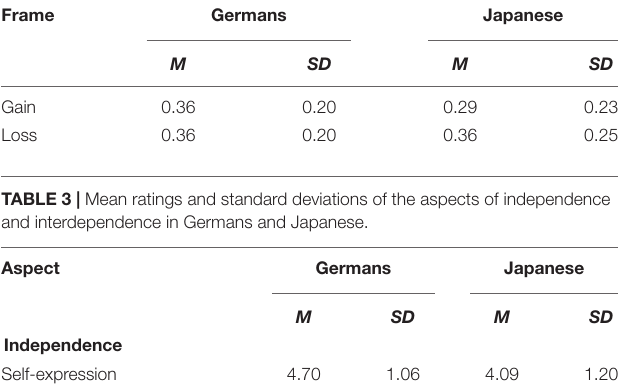
TABLE 2 | Mean AUCs and standard deviations in gain and loss frames in Germans and Japanese. Frame